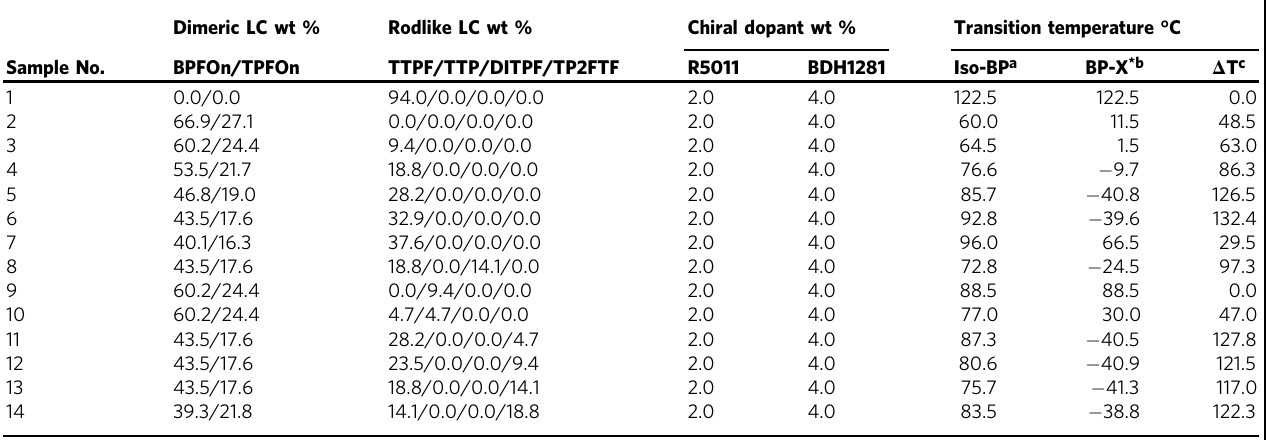
Table 1 Compositions and phase-transition temperatures of the studied samples. Rodlike LC wt % Chiral dopant wt % Transition temperature °C Sample